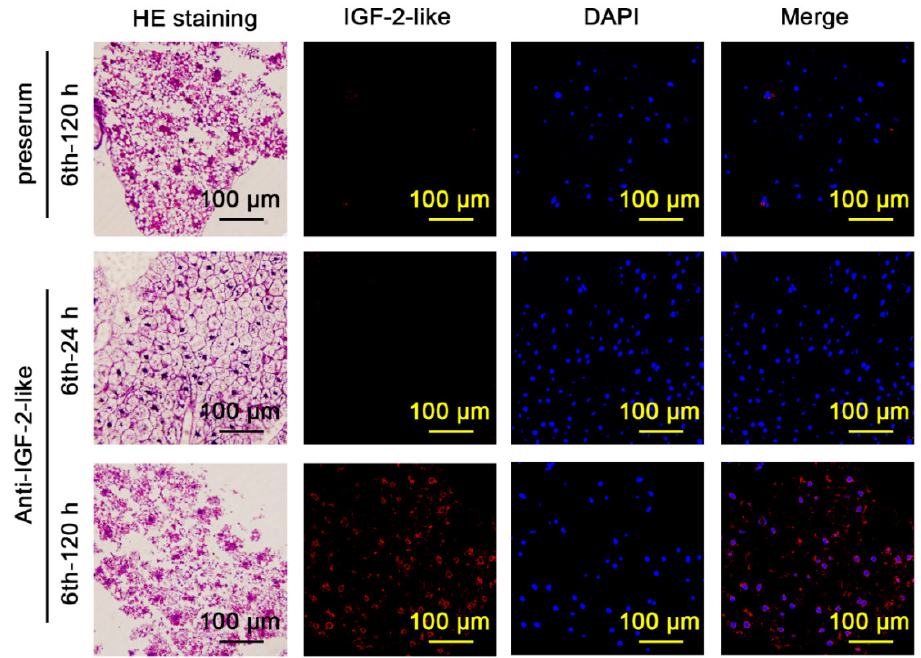
Figure 4. IGF-2-like was localized in imaginal fat body. HE staining showing the fat body structure of corresponding immunofluorescence tissue. Red fluorescence: IGF-2-like detected by anti-IGF-2- like rabbit polyclonal antibodies and Cy3-conjugated goat anti-rabbit IgG (H+L) antibodies. Blue fluorescence: DAPI. Preserum was used as the negative control. Merge: IGF-2-like and DAPI.